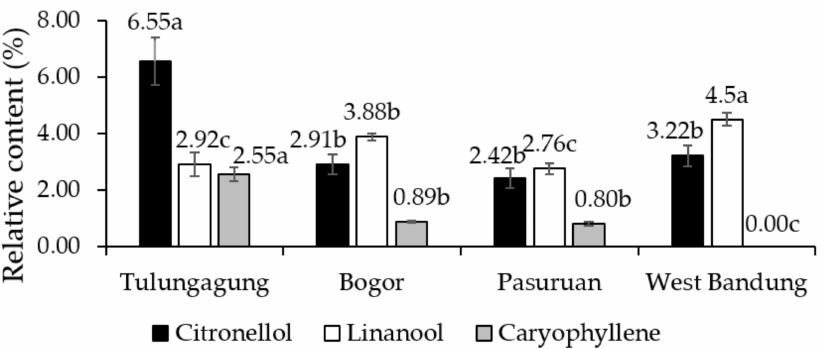
Figure 3. The relative content of citronellol, linalool, and caryophyllene in the GCMS profile of kaffir lime leaves essential oils from four growing locations. Note: the different alphabet above the similar color of rectangular bar is significantly different based on the Duncan’s multiple range test at α 5%; the error bar represents the standard